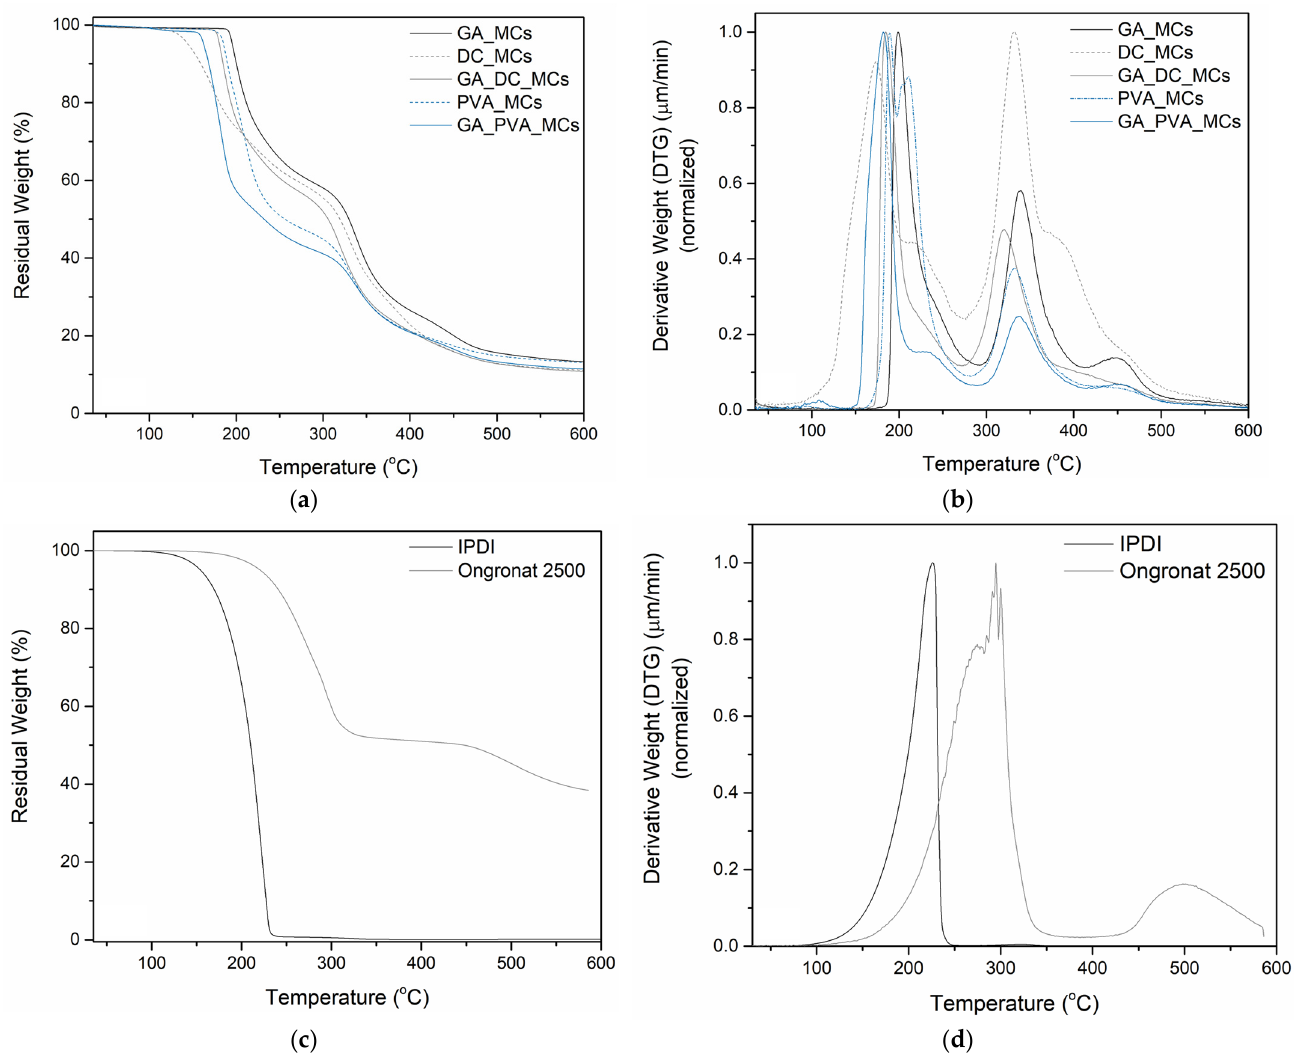
Figure 7. Thermogram of the as-prepared MCs ( a ) and the respective derivative curves ( b ). Thermogram of the isocyanates ( c ) and the respective derivative curves ( d ). Table 3. Mass loss (%) of encapsulated IPDI (by TGA), relative encapsulation Yield (Y) calculated using the FTIR spectra obtained after the synthesis and 3 months later. The Y obtained after the synthesis was calculated using (Equation (2). Y 3 is given as a percentage of Yi.